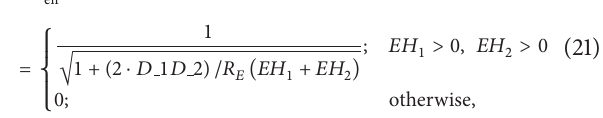
Figure 18: Shadowing effect on the reflected ray.